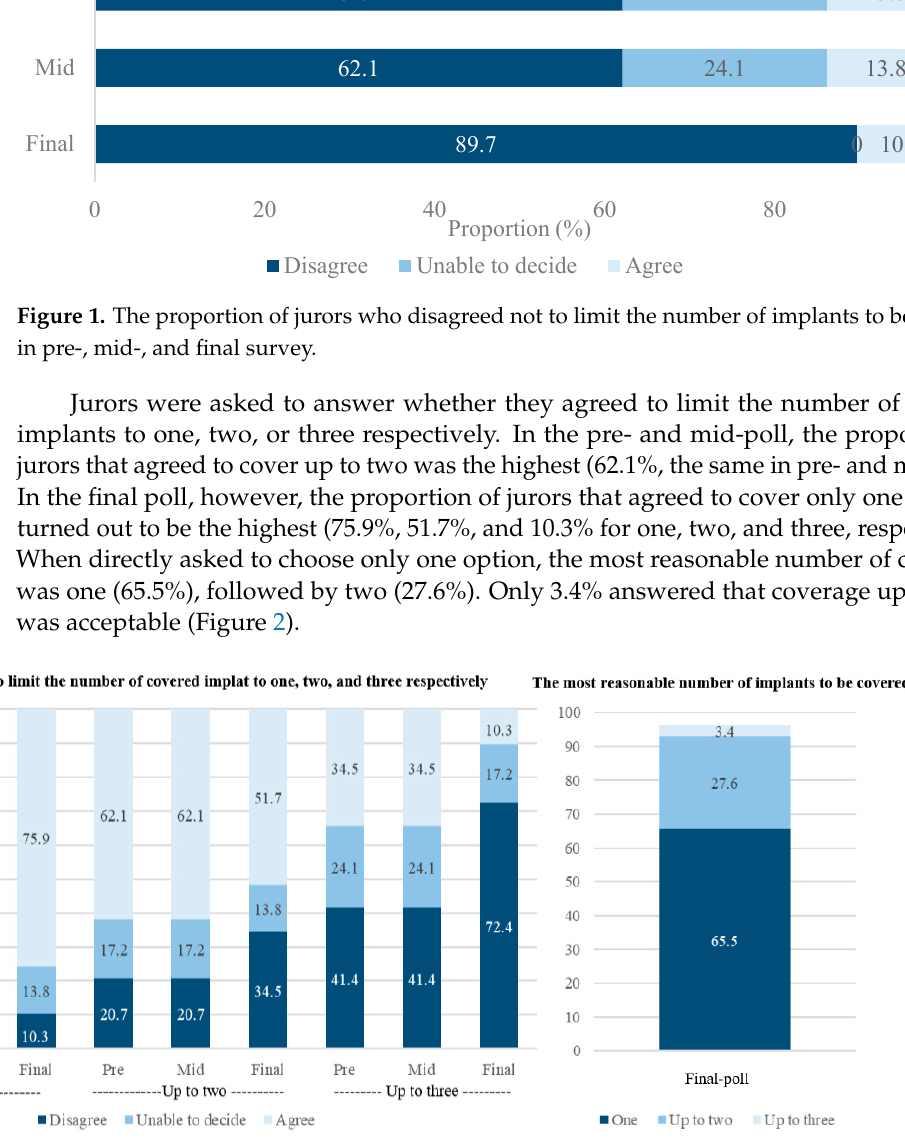
Figure 2. The poll results on the number of dental implants to be